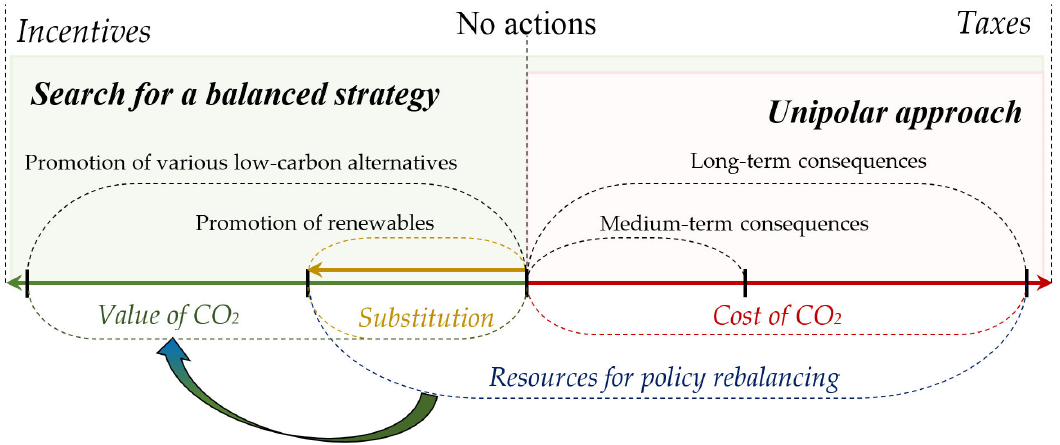
Figure 7. Pathway for climate policy